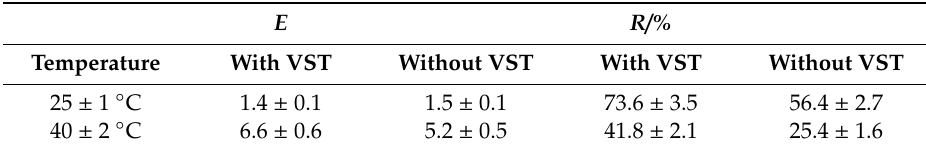
Table 5. E ff ects of vertical sieve trays (VSTs) on enrichment ratio ( E ), and recovery percentage ( R ) of total anthraquinones at temperatures 25 ± 1 ◦ C and 40 ± 2 ◦ C.